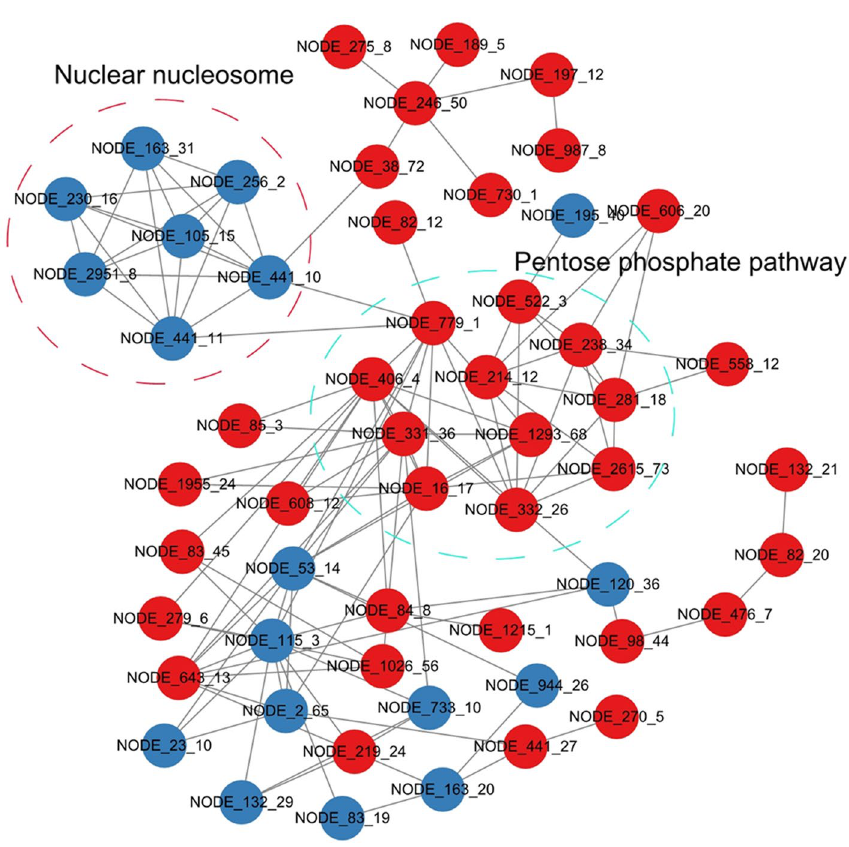
Figure 8. Protein–protein interaction network of differentially regulated modification sites in C. chloroleuca